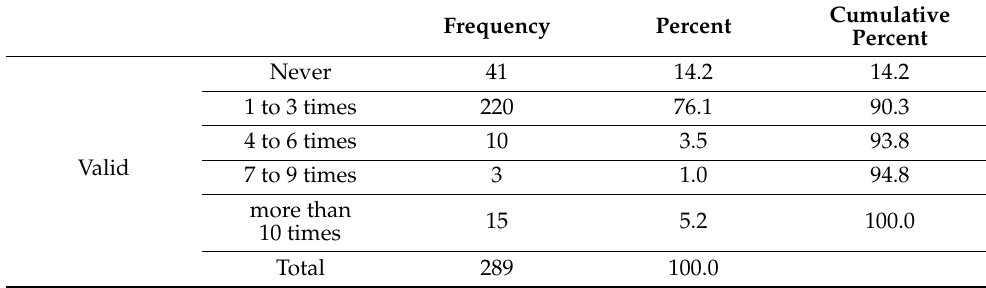
Table 5. Frequency purchase